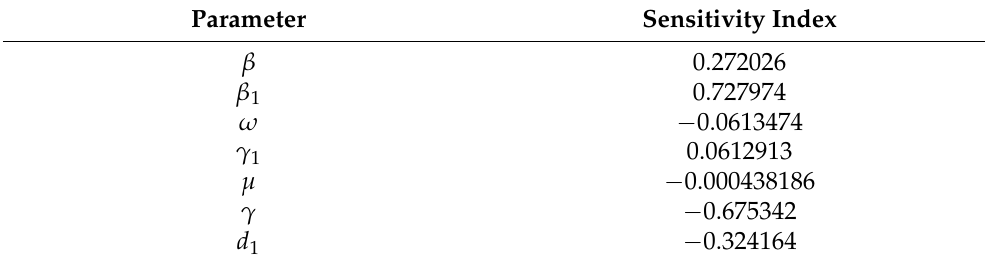
associated to their 0